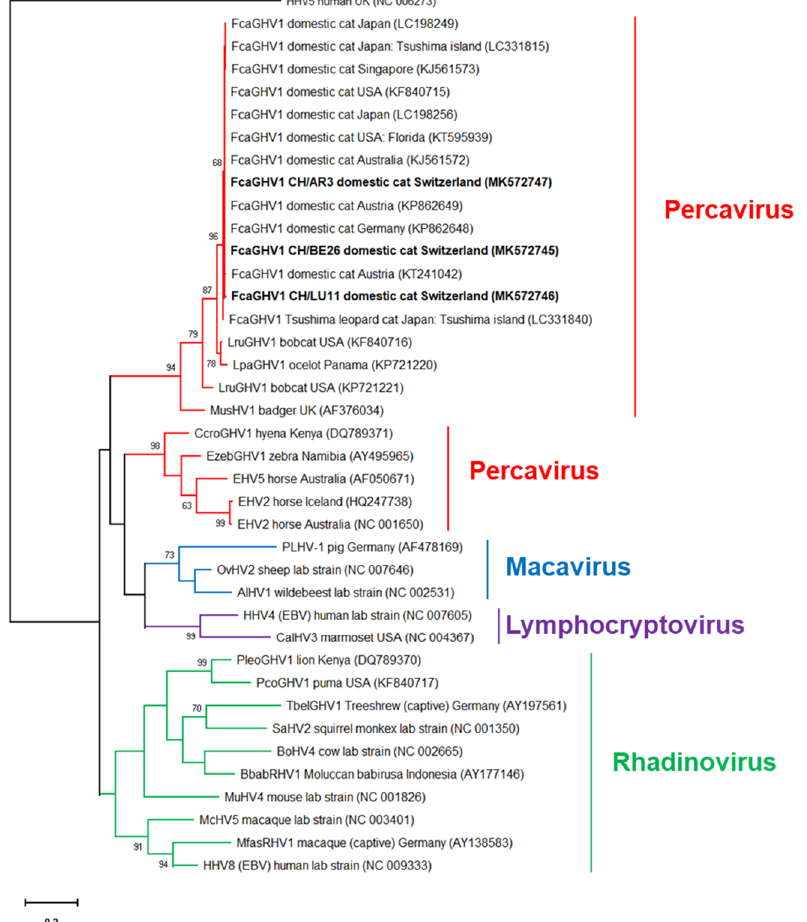
Figure 3. Molecular phylogenetic analysis by the maximum likelihood method of gammaherpesviruses using the glycoprotein B gene. The evolutionary history was inferred using the maximum likelihood method based on the Kimura 2-parameter model [63]. The tree with the highest log likelihood (-6535.03) is shown. The percentage of trees in which the associated taxa clustered together is shown next to the branches. The gammaherpesvirus genera (Percavirus, Macavirus, Lymphocryptovirus and Rhadinovirus) are shown in color. Initial tree(s) for the heuristic search were obtained automatically